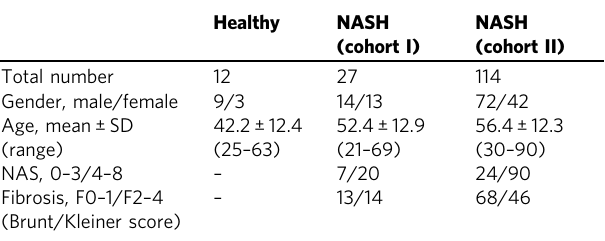
Table 1 Characteristics of the healthy human subjects and treatment-naive patients with biopsy-proven